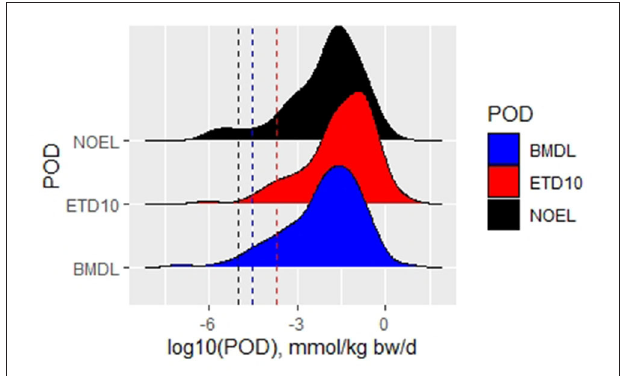
FIGURE 3 | Density plot with histograms for different types of PODs with indication of the respective fifth percentiles by dotted lines in respective colors.